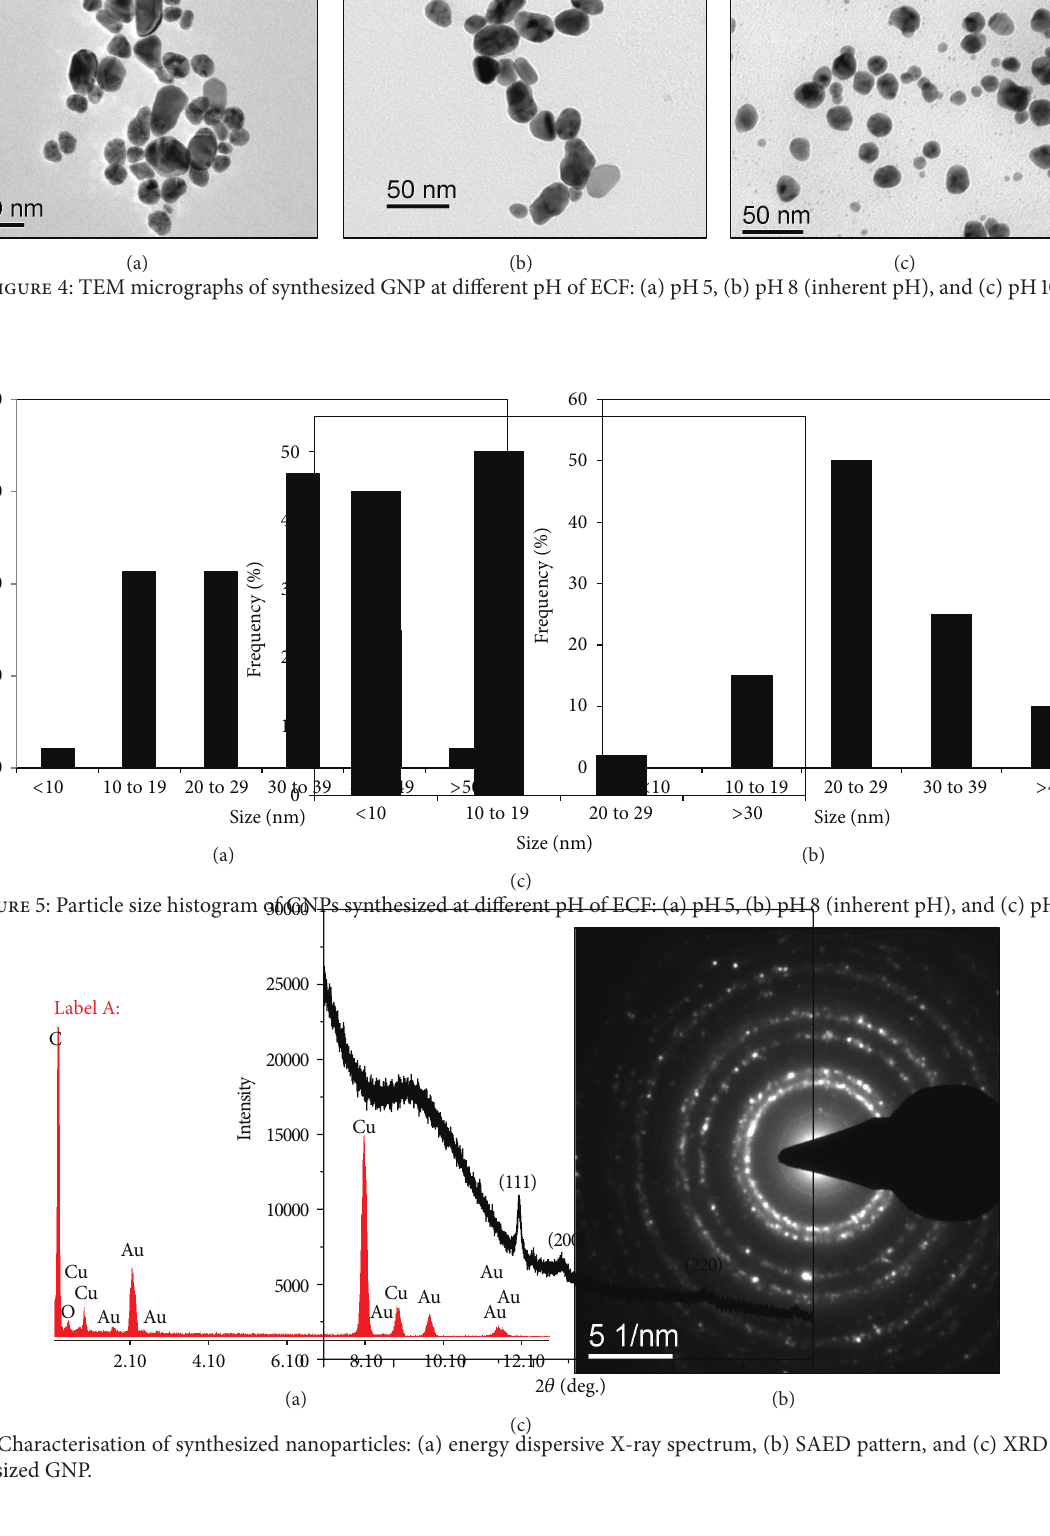
Figure 6: Characterisation of synthesized nanoparticles: (a) energy dispersive X-ray spectrum, (b) SAED pattern, and (c) XRD analysis of the synthesized